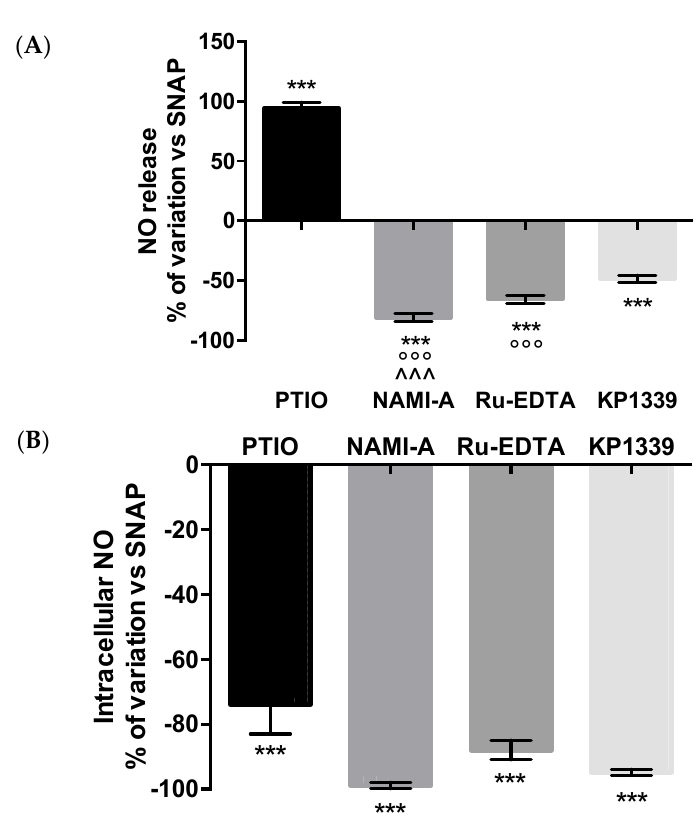
Figure 7. Effects of the contemporary treatment with NAMI-A, Ru-EDTA, KP1339, and PTIO on SNAP induced NO production/release by EA.hy926 cells. EA.hy926 cells were treated with 10 − 4 M SNAP ± an equimolar concentration of compounds for 2 h. Then, NO was measured in the extracellular medium by Griess test ( A ) or at intracellular level by the fluorescent dye DAF-2 DA; ( B ) Data are expressed as per cent of variation vs. SNAP treated cells and are the mean ± S.E.M. of five samples per group. ANOVA and Tukey–Kramer: *** p < 0.001 vs. Control, °°° p < 0.001 vs. KP1339; ^^^ p < 0.001 vs. Ru-EDTA.